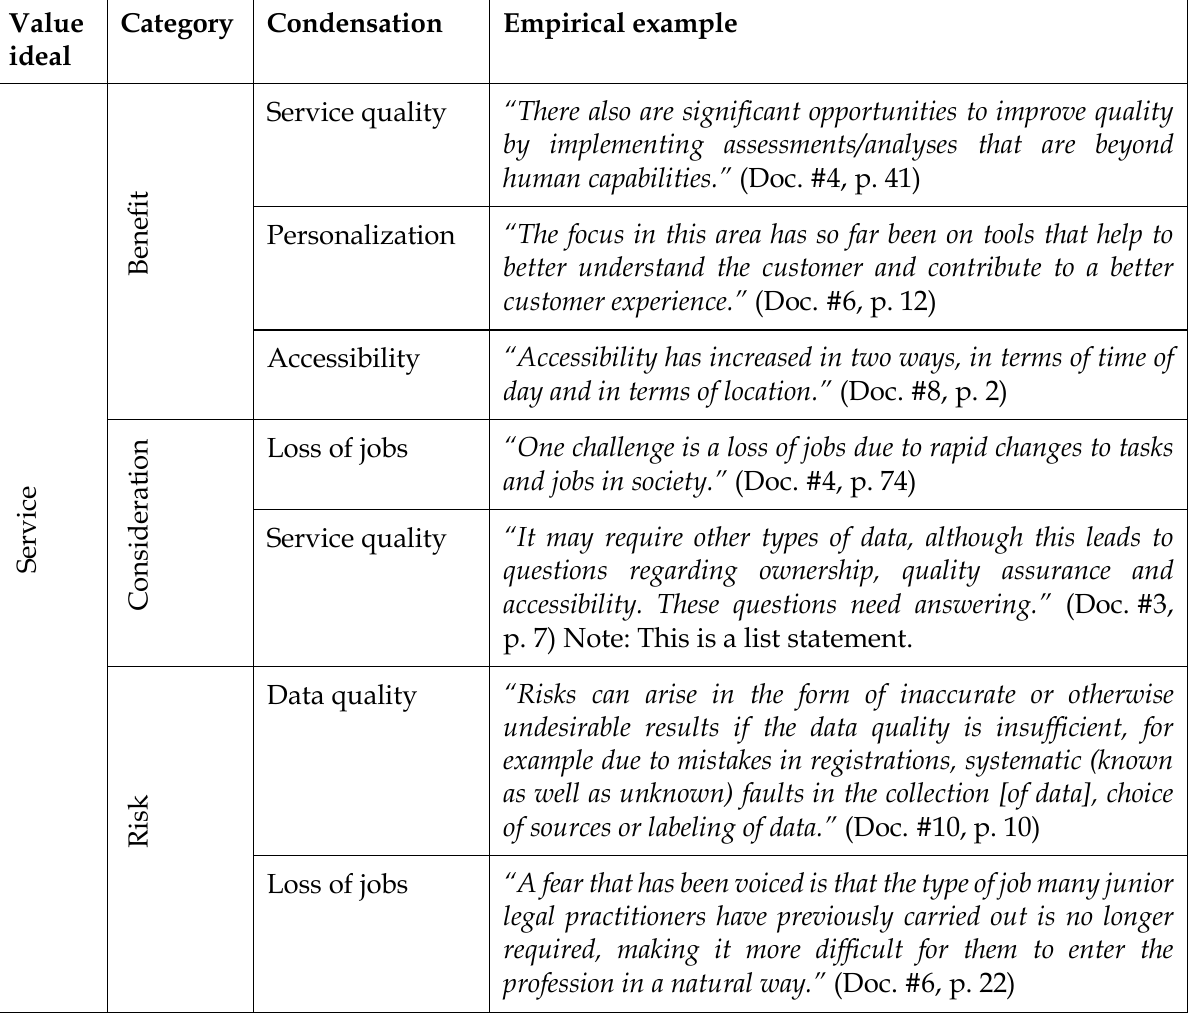
Table 5. Empirical examples of condensations and their categories fo r the ‘Service’ value ideal. Value